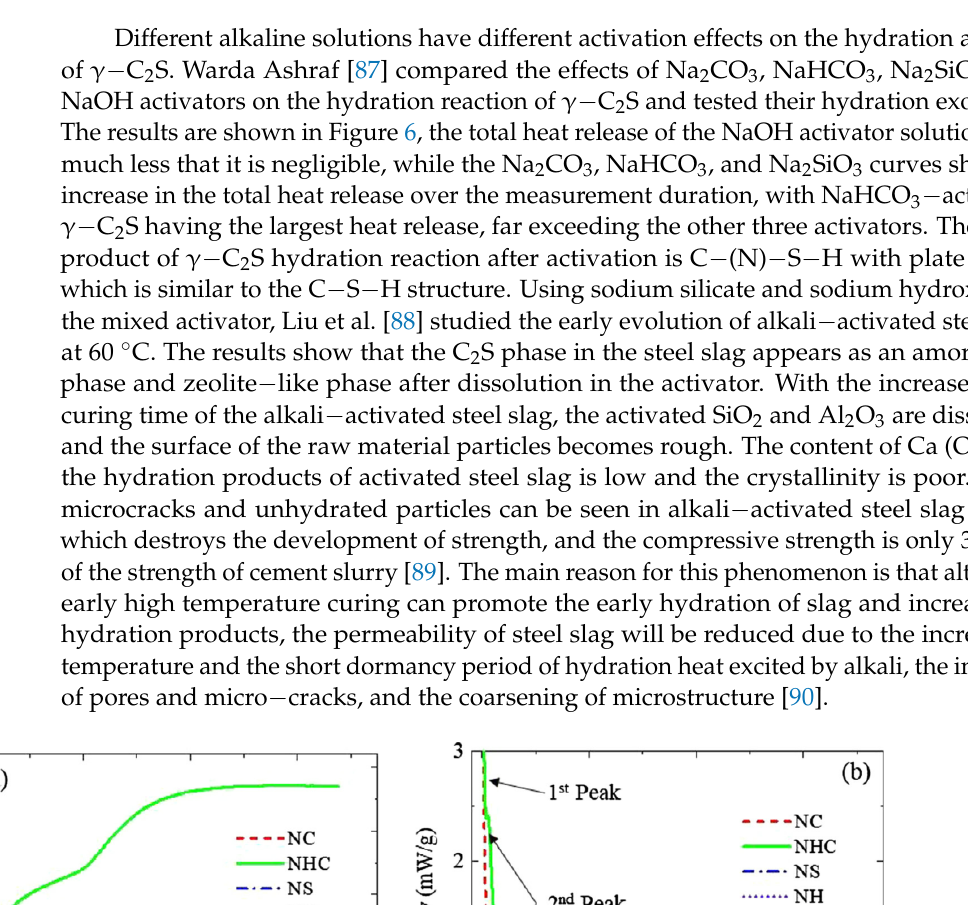
Figure 5. Schematic diagram of [SiO 4 ] tetrahedron depolymerization to generate H 3 SiO 4 − .